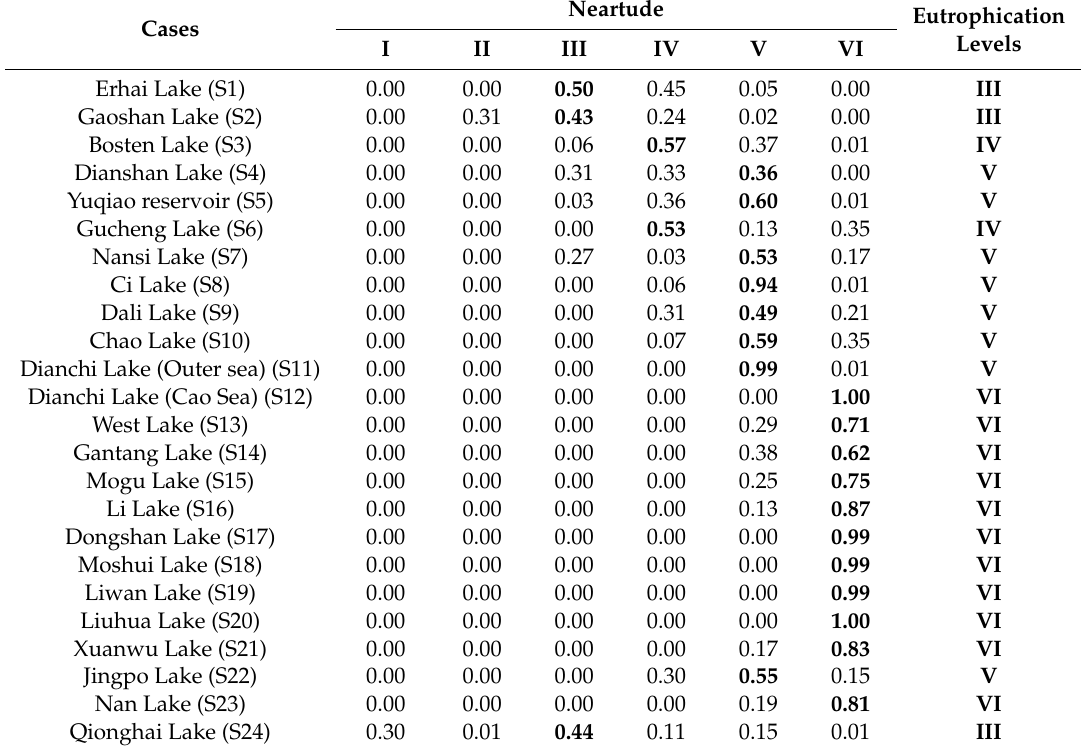
Table 5. Results by cloud matter element model-based assessment